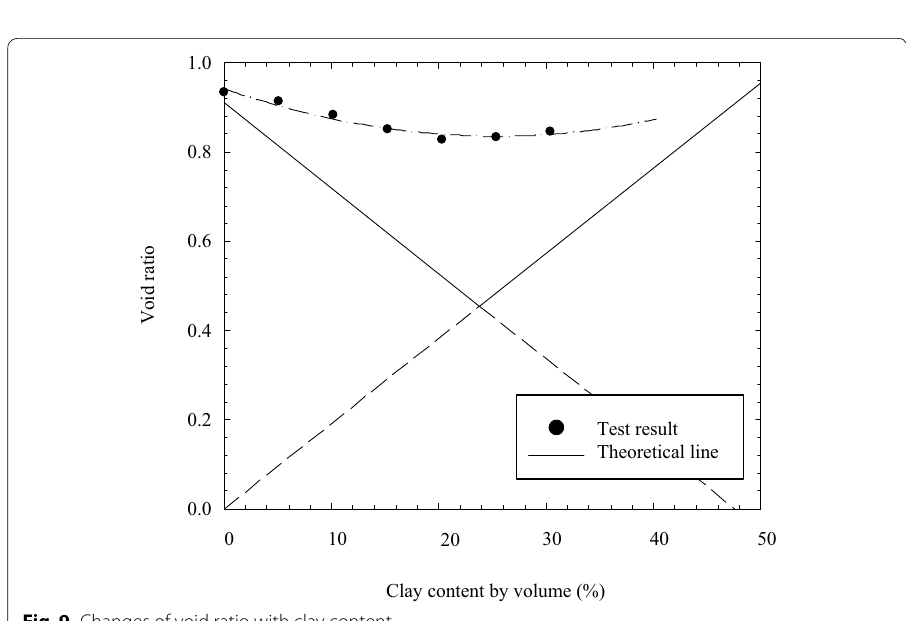
Fig. 9 Changes of void ratio with clay